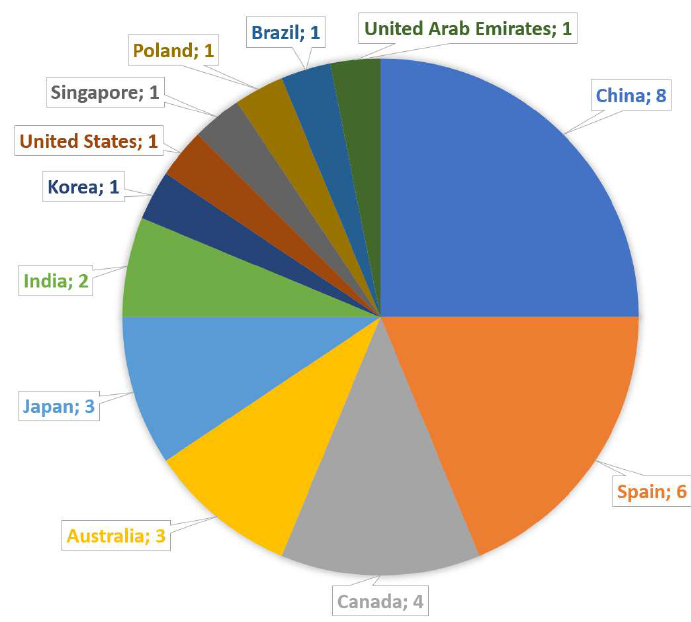
Figure 8. Countries included in T- and ST- BIPV simulation studies.